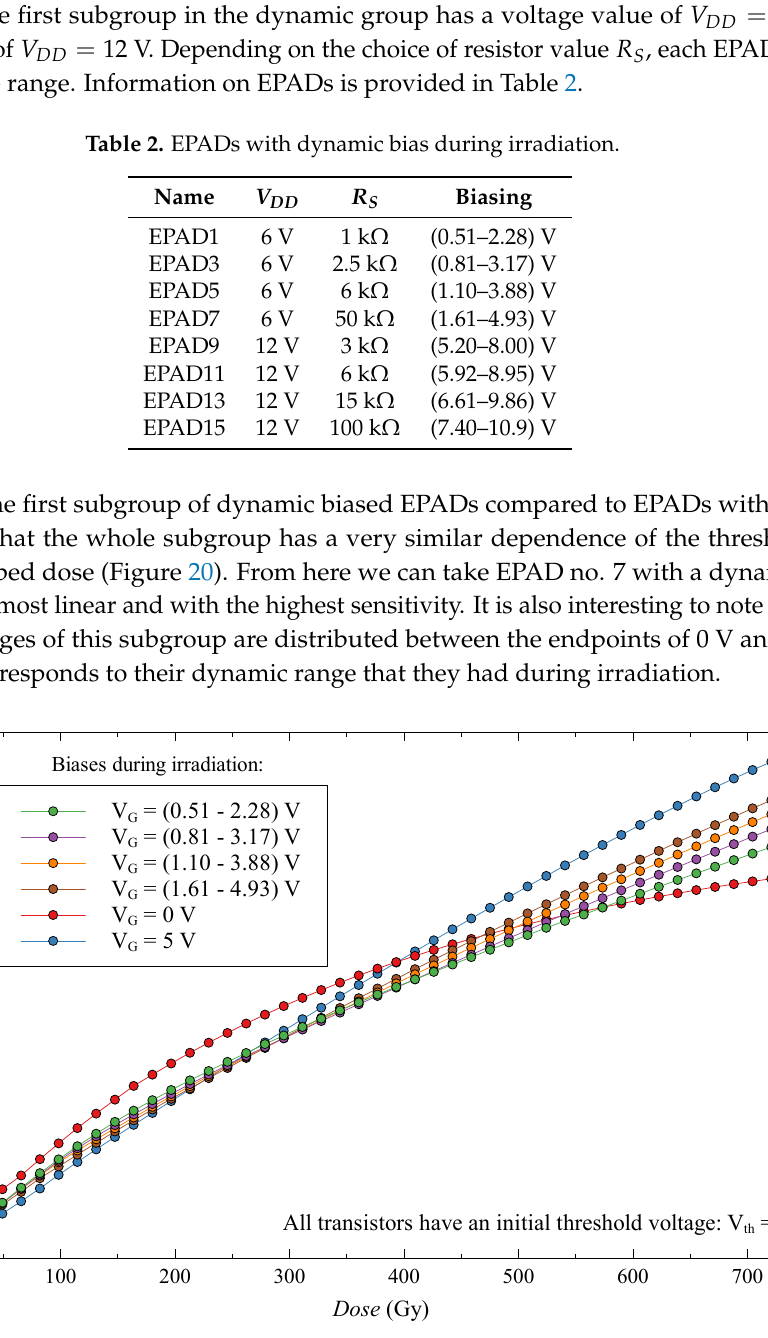
Figure 20. Threshold voltage shift for first subgroup of EPADs with dynamic 6 V bias during